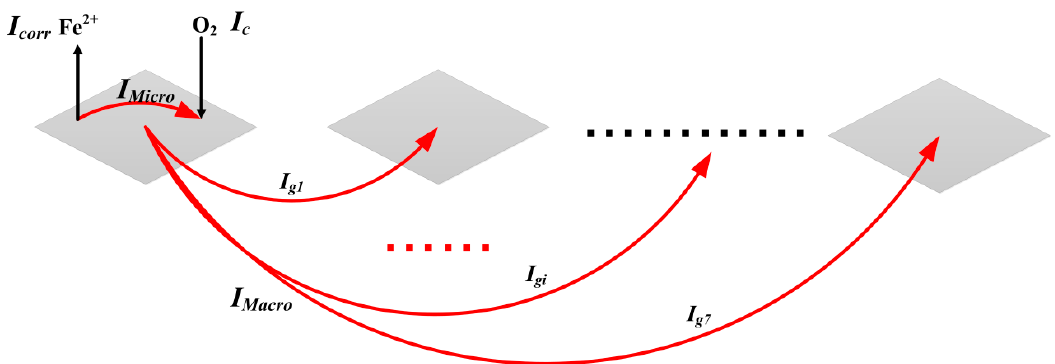
Figure 8 Representation of the macro current among the electrodes and microcurrent within the corroding electrode.